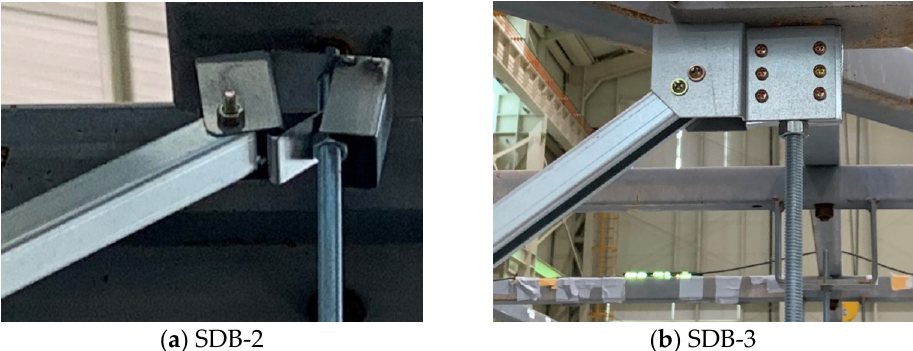
Figure 11. Brace–hanger bolt connection, Test 8 (2.16 g), ( a ) yield of the SDB-2 connection and ( b ) SDB-3.